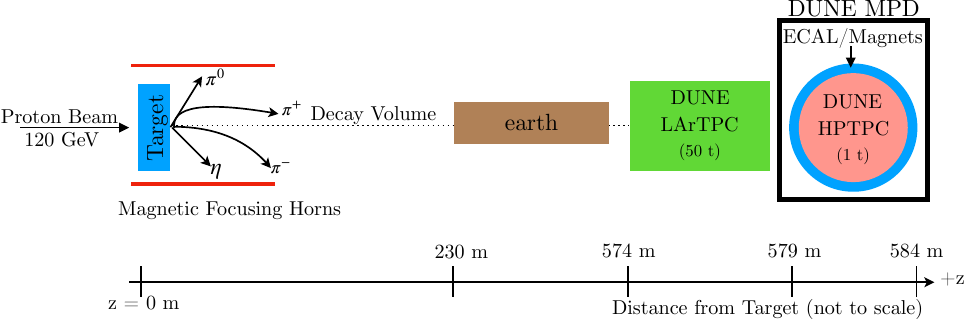
Figure 1 . Schematic layout of the DUNE beam, target, and near detectors. The z axis represents the beam direction; z = 0 m corresponds to the front of the target, z = 574 m corresponds to the front of the liquid argon near detector, and z = 579 m corresponds to the front of the multi-purpose detector. The masses listed with the two detector components are the expected (cid:12)ducial